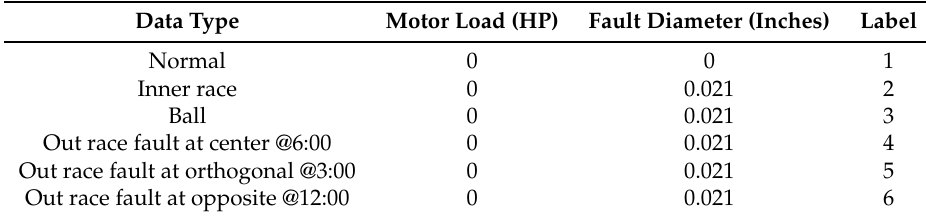
Table 1. Description of CWRU dataset.